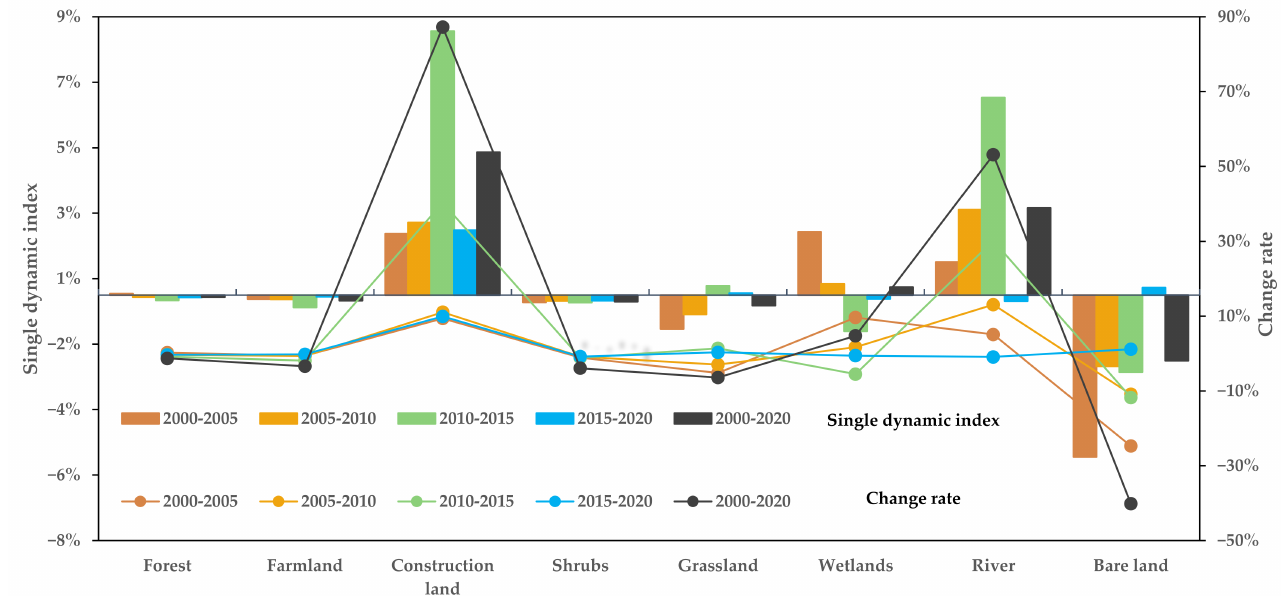
Figure 4. Single dynamic index and change rate of land use types in Hainan from 2000 to